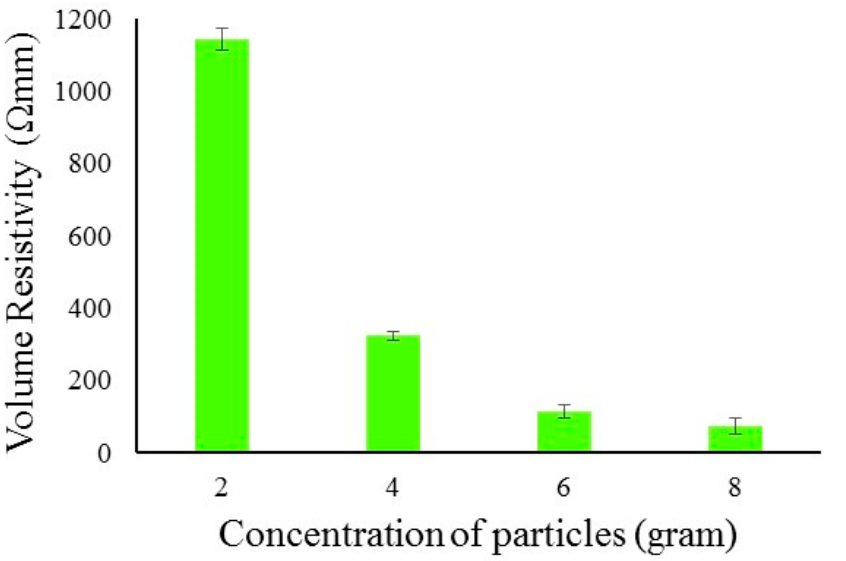
Figure 11. Electrical resistivity of conductive paste.